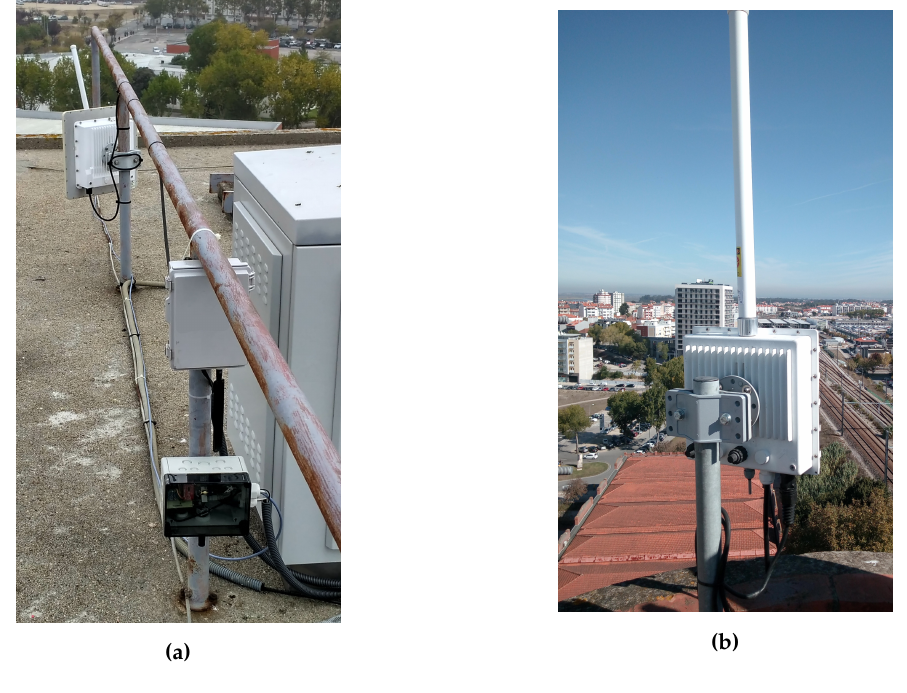
Figure 7. LoRa gateway deployment ( a ) LoRa gateway deployed in the University of Aveiro; ( b ) LoRa gateway deployed in Aveiro’s Cultural and Congress Center.